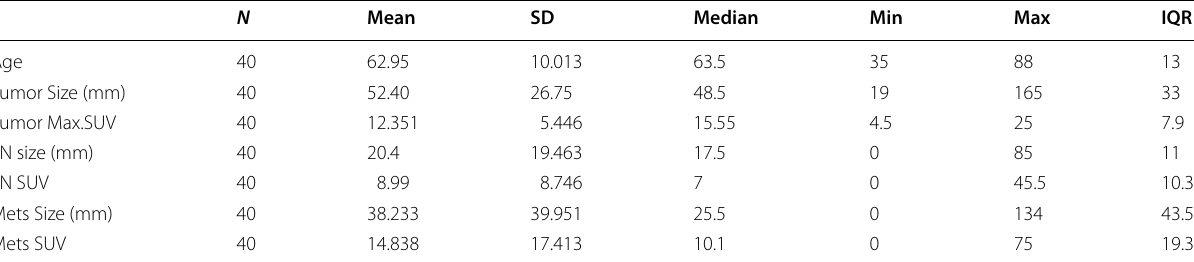
SD standard deviation, IQR interquartile rang